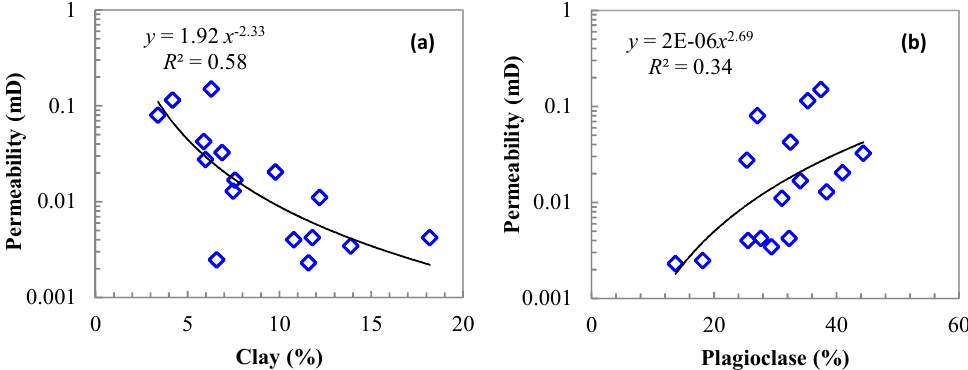
Figure 5. The cross plot of permeability with clay and plagioclase contents.